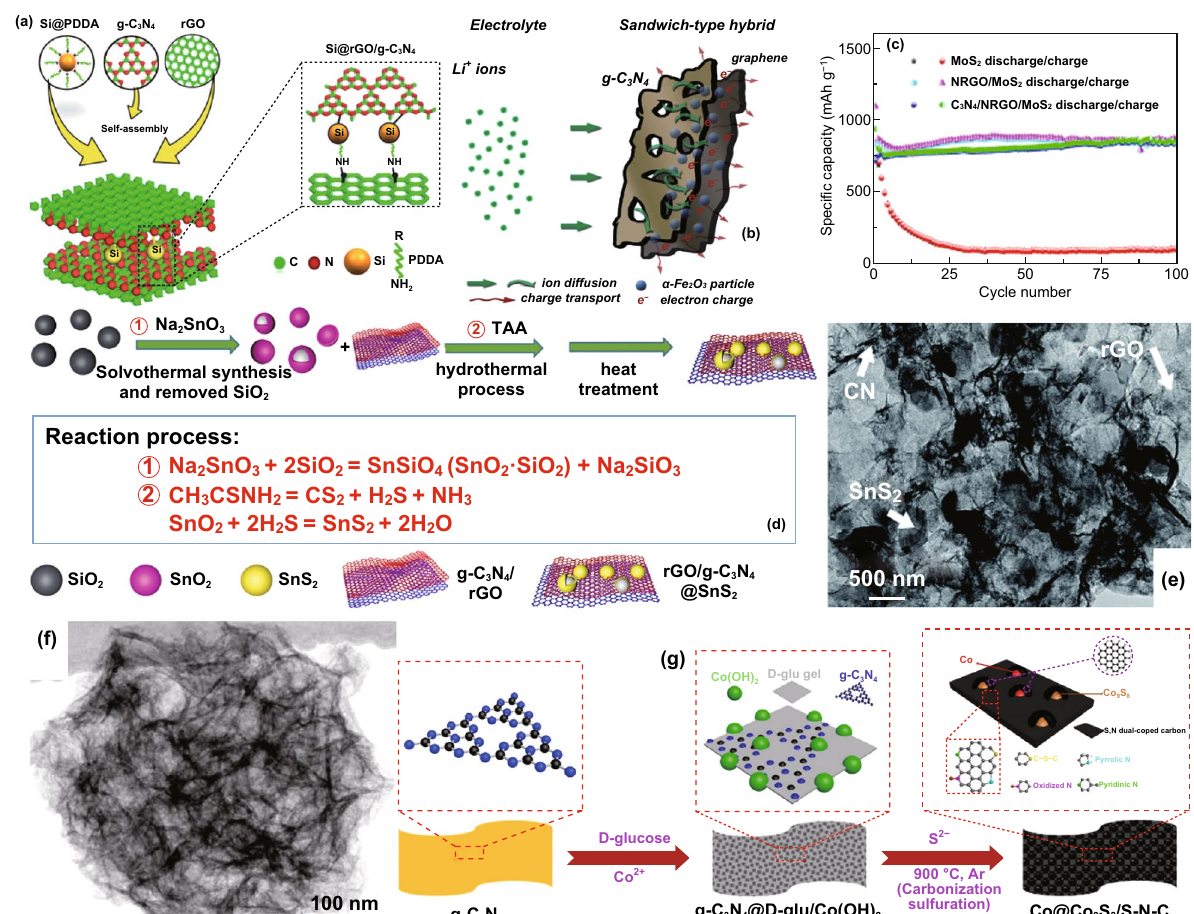
Fig. 19 a Schematic reaction scheme of the Si@rGO/g-C 3 N 4 hybrid and illustration of Si NPs anchored on rGO/g-C 3 N 4 via strong covalent and hydrogen bonding formed during the pyrolysis process. Reproduced with permission from Ref. [118]. b Schematic diagram of ionic diffusion and charge transport in the porous Fe 2 O 3 /CN–G anode with a 2D sandwich-like nanosheet architecture. Reproduced with permission from Ref. [124]. c Cycle performance over the voltage range of 0.01–3.0 V vs. Li/Li + at the same current density of 100 mA/g for MoS 2 , NRGO/MoS 2 , and C 3 N 4 / NRGO/MoS 2 . Reproduced with permission from Ref. [121]. d Schematic synthesis process of rGO/g-C 3 N 4 @SnS 2 . Reproduced with permission from Ref. [123]. e TEM micrograph of porous ternary composite architectures of reduced graphene oxide, SnS 2 , and CN (GSC6). Reproduced with permission from Ref. [122]. Copyright permissions from Royal Society of Chemistry, Elsevier, and Springer Nature. (Color figure